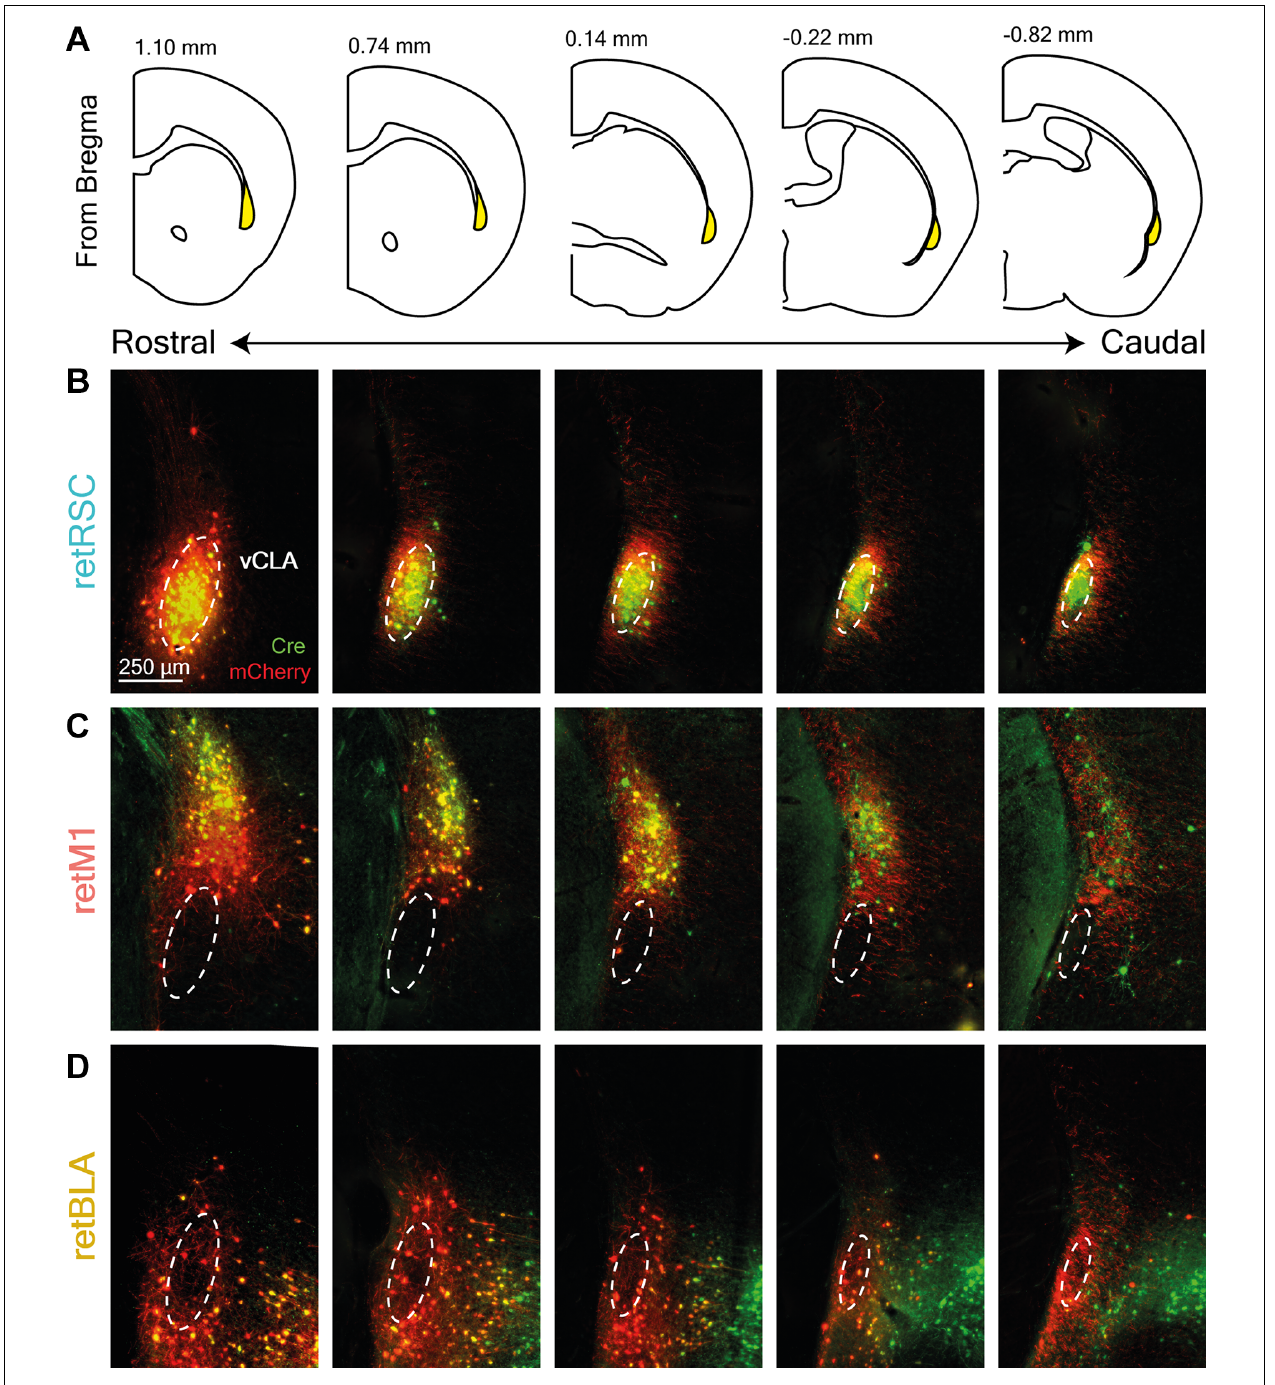
FIGURE 2 | Topological zones in the CLA are maintained throughout the rostral-caudal axis. (A) Diagram of coronal sections corresponding to CLA images shown in (B–D) . The CLA is highlighted in yellow and the distance from the bregma is indicated at the top. (B–D) Examples of retrograde Cre (green) and conditional mCherry (red) expression across the entire rostral-caudal extent of the CLA (columns). Each row corresponds to a different initial target: (B) RSC-projecting (retRSC), (C) BLA-projecting (retBLA), and (D) M1-projecting (retM1). Dotted white ellipses demarcate the ventral CLA core (vCLA) based on parvalbumin staining (not shown).